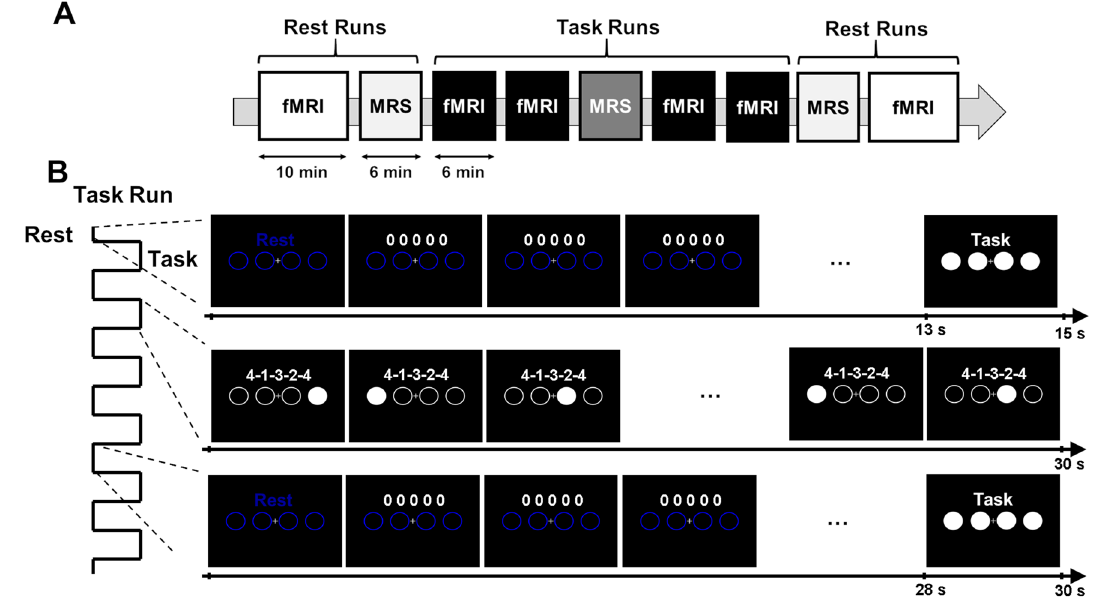
Figure 1. Experimental design. ( A ) The timeline of combined functional magnetic resonance imaging (fMRI) and magnetic resonance spectroscopy (MRS) sessions. The experiment consists of the pre-learning rest session, followed by the task and post-learning rest sessions. During the rest of the sessions, fMRI and MRS scans are conducted before and after motor sequence learning. Meanwhile, during the task session, participants had undergone four fMRI scans and one MRS scan with sequential finger-tapping learning tasks. ( B ) Task design. Each task run (1–5) consists of six cycles of task and rest epochs. Prior to task execution, participants are instructed to retrieve and prepare for the motor sequences following the instructions and closed circles. Participants were indicated using a five-digit sequence (e.g., “4-1-3-2-4”) for 30 s during the task epoch. During the rest epoch, four open blue circles were